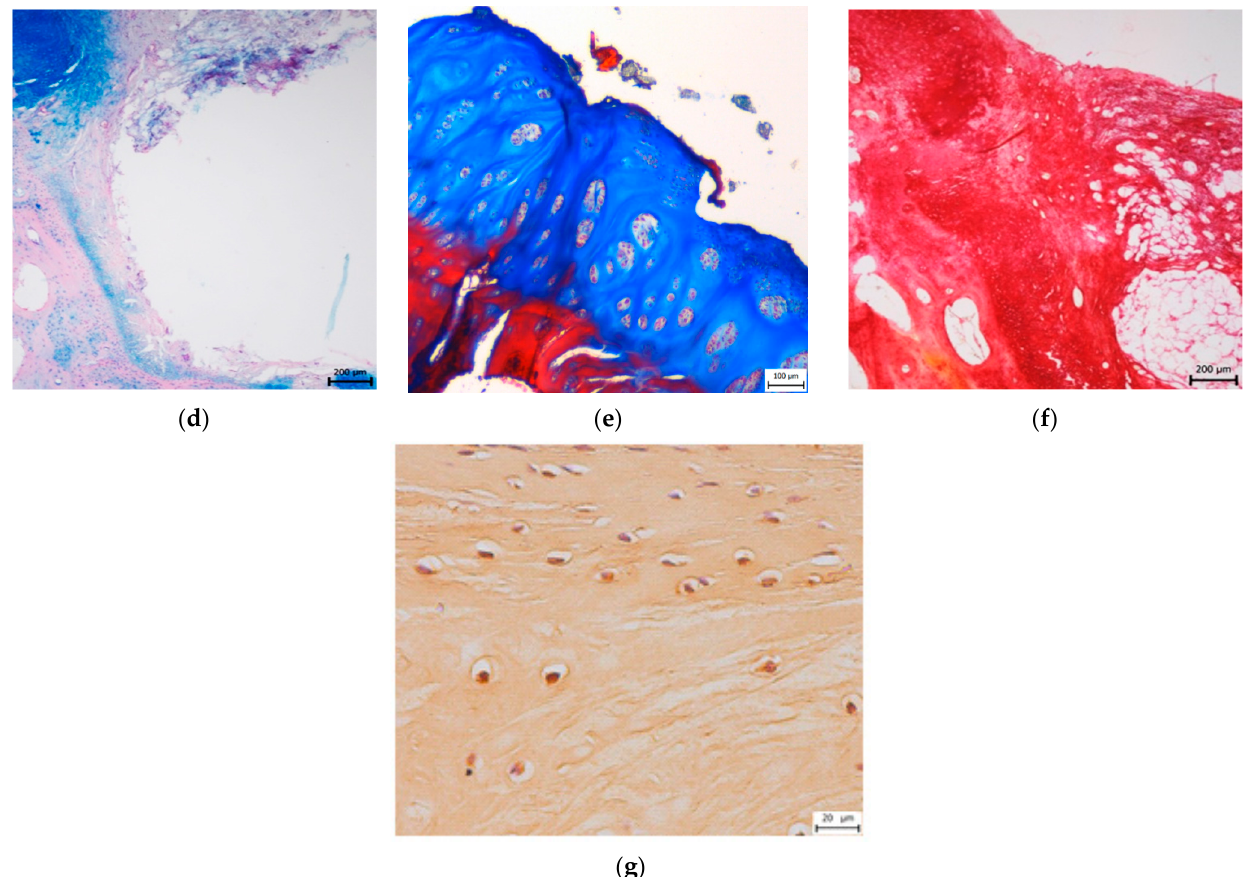
Figure 5. Histological evaluation of untreated defects left for spontaneous healing at 6 months post ‐ operation. The untreated defect resulted in marked differences in cellular organization, mainly showing fibrocartilage, fibrous tissue, and disorganized tissue. ( a ) Hematoxylin ‐ eosin staining showed no typical cell morphology and no cartilage tissue. The irregular surface was covered by a large quantity of fibrous tissue. ( b ) The defect showed almost negative Safranin O staining and chondrocyte clusters and hypocellular areas were found. ( c , d ) The deep fissure and decreased staining for Alcian blue were detected. The scale represents 200 μ m . ( e ) The collagen distribution and chondrocyte cluster formation were observed, Masson´s trichrome (scale bar 100 μ m). ( f ) Inhomogeneous tissue stained with Picrosirius red (scale bar 200 μ m). ( g ) immunohistochemical staining of the type I collagen (scale bar 20 μ m).